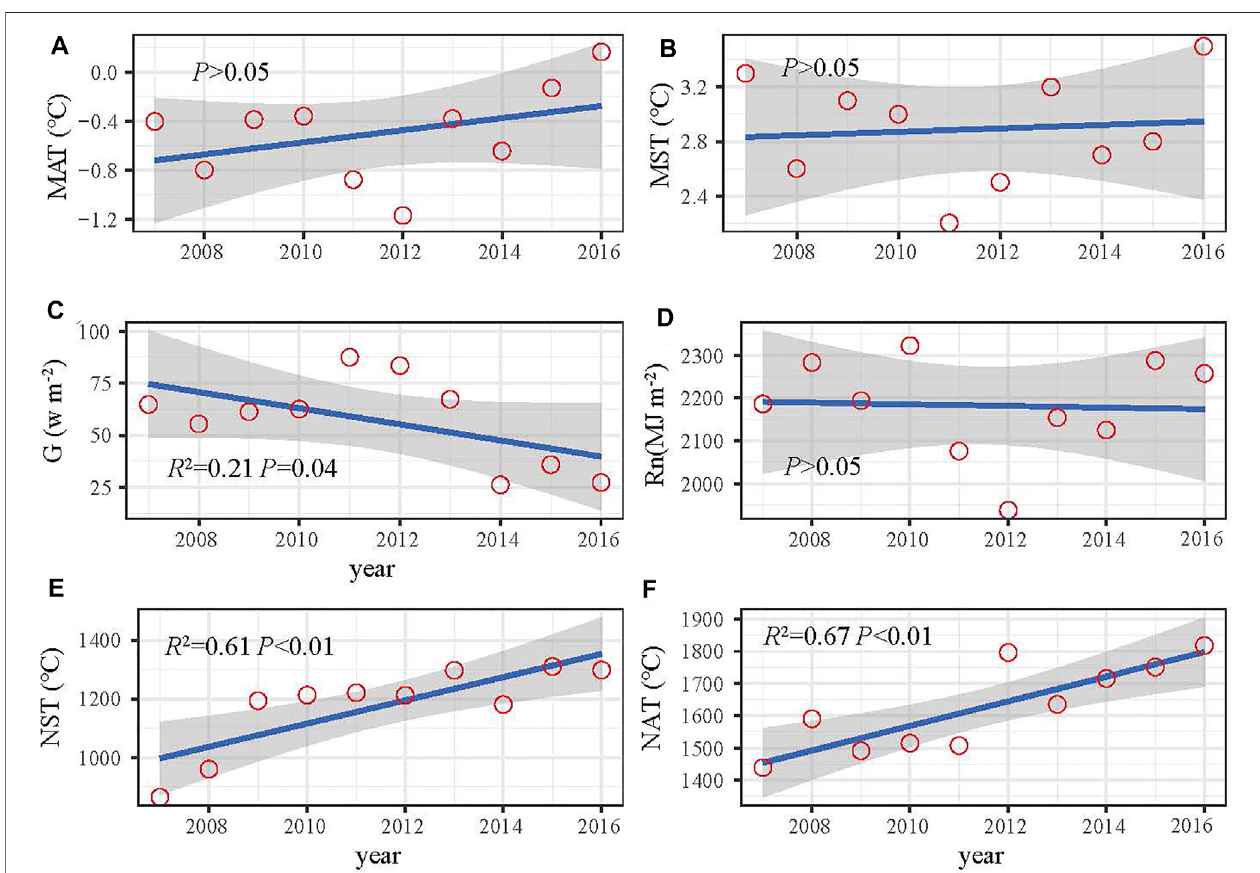
FIGURE3| Inter-annualvariationofenvironmentalfactors, (A) meanairtemperature(MAT), (B) meansoiltemperature (MST), (C) soilheat fl ux(G), (D) netradiance (R n ), (E) negative accumulated temperature of soil temperature (NST), and (F) negative accumulated temperature of air temperature (NAT).